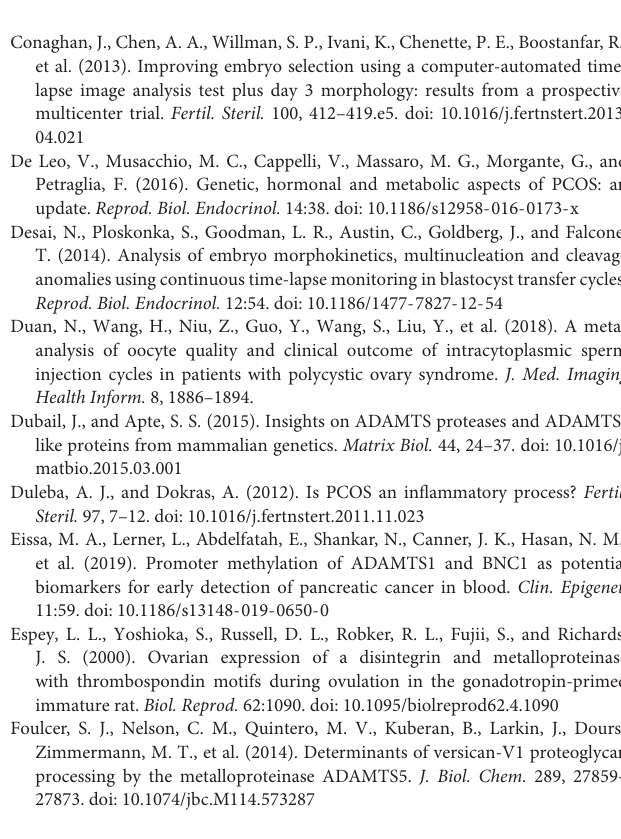
Supplementary Figure 1 | The verification of the down-regulation of ADAMTS1 in granulosa cells. The verification of the down-regulation of ADAMTS1 in granulosa cells by real-time PCR and western blot analysis (A,B) . si-Ctrl was used as control, ∗∗∗∗ indicates p < 0.0001. Supplementary Figure 2 | The negative control of immunofluorescence in granulosa cells. The negative control was stained with rabbit IgG instead of ADAMTS1 primary antibody (A) . The negative control was stained with 5% BSA (B) . Blue, DAPI indicates the nuclear localization signal. Bar = 20 µ m. Supplementary Figure 3 | The negative control of immunofluorescence in granulosa cells. The negative control was stained with mouse IgG instead of Ki-67 primary antibody (A) . The negative control was stained with 5% BSA (B) . Blue, DAPI indicates the nuclear localization signal. Bar = 20 µ m. Supplementary Figure 4 | The negative control of immunofluorescence in embryos. The negative control was stained with rabbit IgG instead of ADAMTS1 primary antibody (A) . The negative control was stained with 5% BSA (B) . Blue, DAPI indicates the nuclear localization signal. Bar = 50 µ